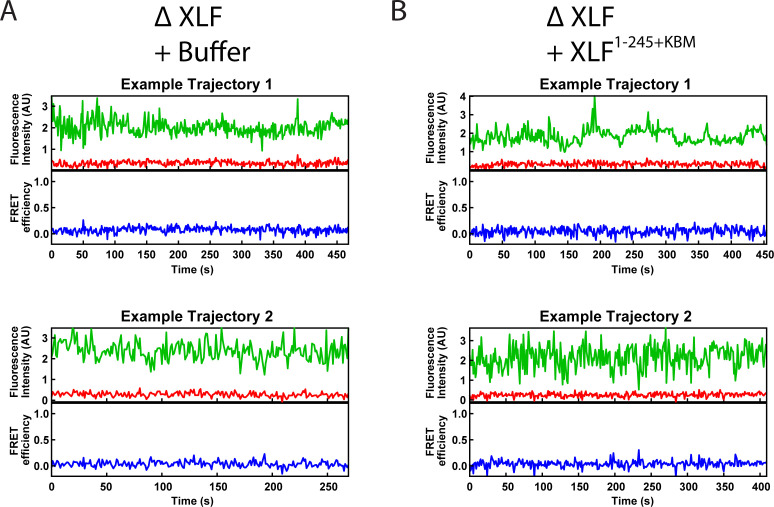
Example smFRET trajectories.(A, B) Example trajectories from the smFRET SR Complex formation assay for the ΔXLF + Buffer and the ΔXLF + XLF1-245+KBM conditions. Donor and acceptor fluorescence intensity are shown in green and red, respectively. The corresponding FRET efficiency from each trace is shown in blue in a separate trajectory below.